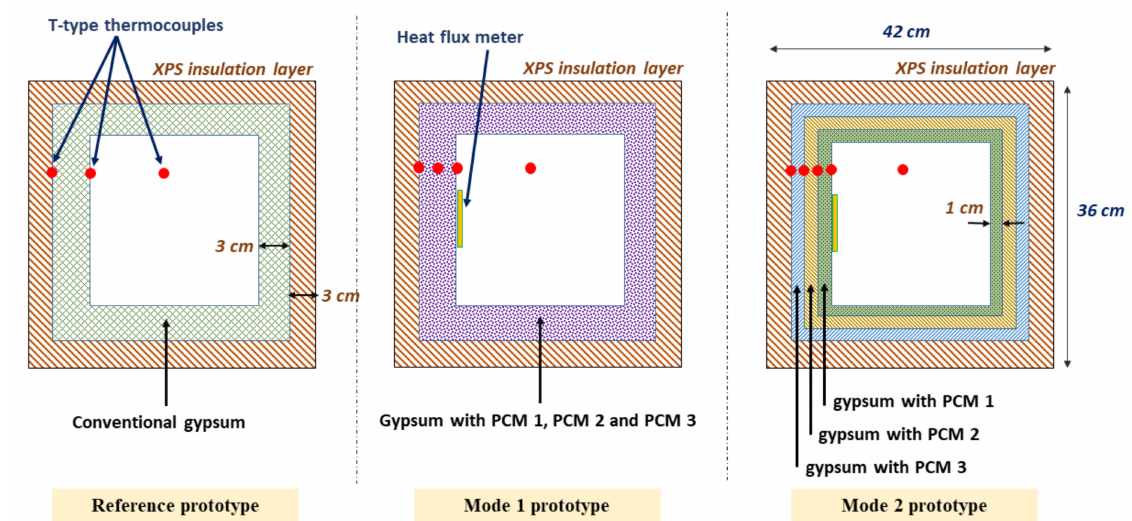
Figure 12. Experimental reduced-scale prototypes with PCM wallboards of different modes